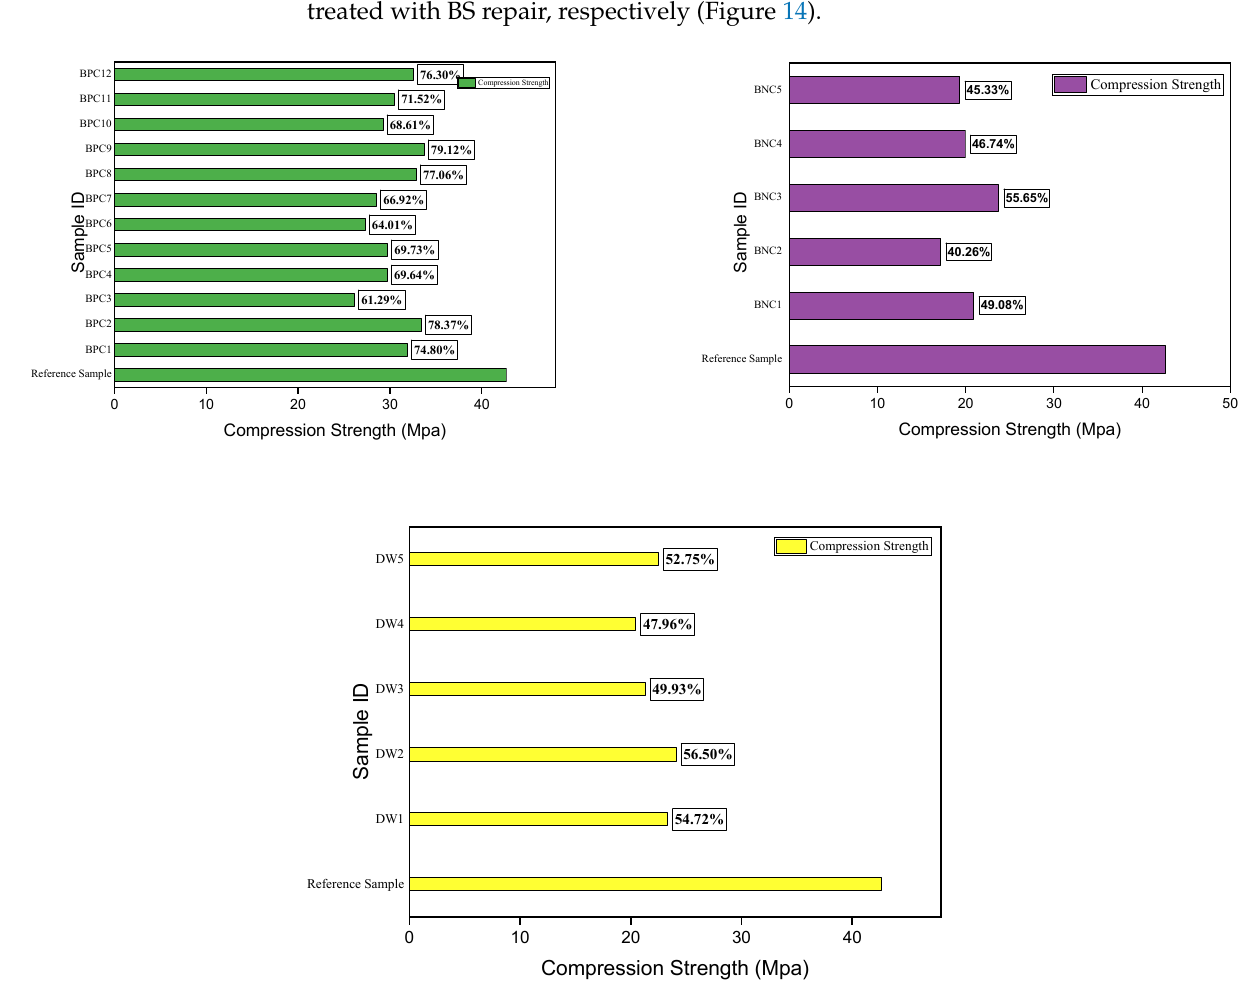
Figure 14. Recovered compressive strength after different repair treatments.